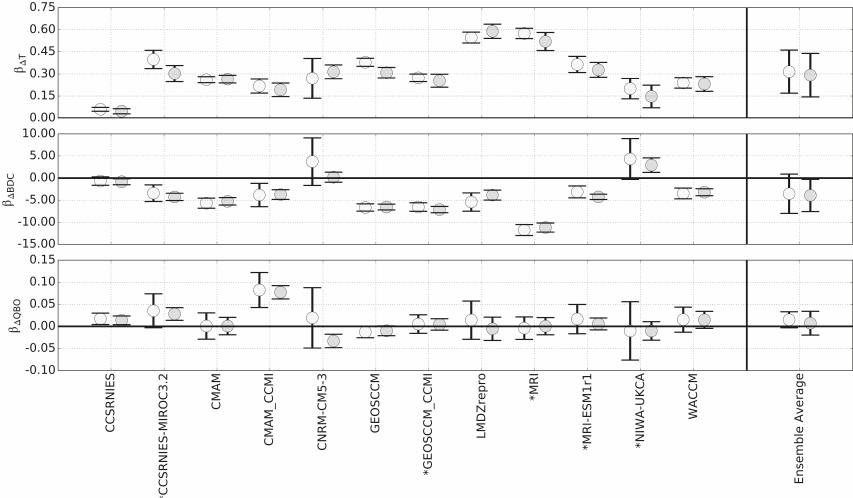
Figure 3. Circles show detrended (light grey) and trended (dark grey) coefficients for each model; error bars correspond to 95th percentile confidence interval bounding each regression coefficient. An asterisk indicates models simulating a QBO. The ensemble mean corresponds to the average of all model coefficients. The ensemble mean coefficients are also represented by a circle, with associated error bars corresponding to ± 1 standard deviation of the ensemble. The units of β (cid:49)t , β BDC , and β QBO are ppmvK − 1 , ppmv (K/day) − 1 , and ppmv, respectively. Table 2. Coefficients ( β s) from regressions of trended [ H 2 O ] entry time series, and the change in [ H 2 O ] entry resulting from each process ( β STD()), where STD() is the standard deviation of each trended process. Trended regression CCM